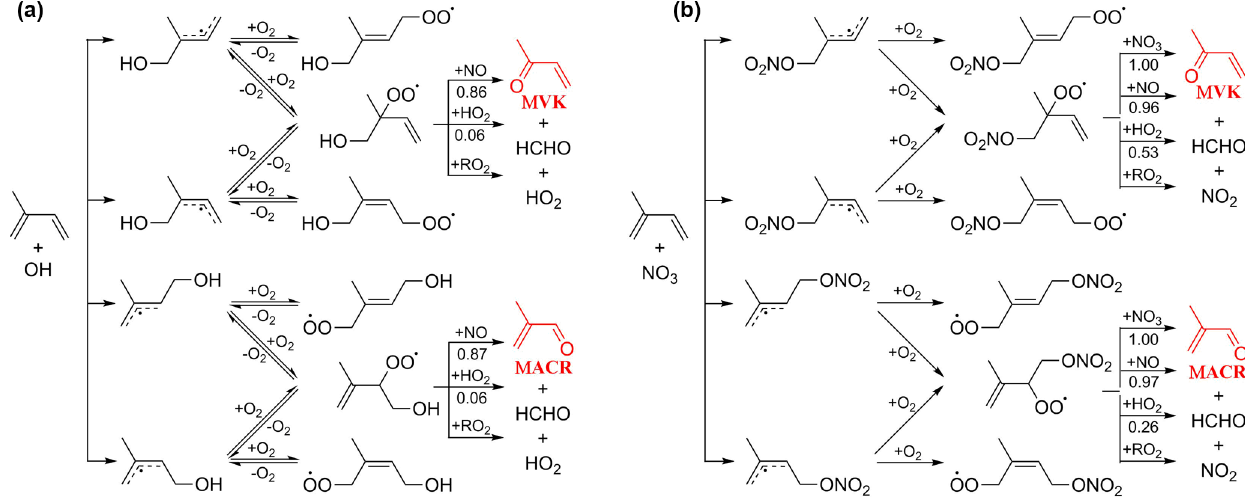
Figure 2. Representative mechanism for (a) OH- and (b) NO 3 -initiated oxidation of isoprene that leads to the formation of MACR and